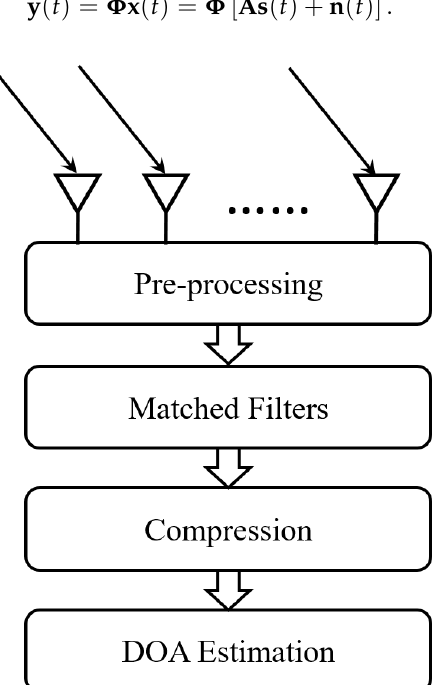
Figure 1. System configuration of the proposed compressive measurement (CM)-multiple-input multiple-output (MIMO) radar